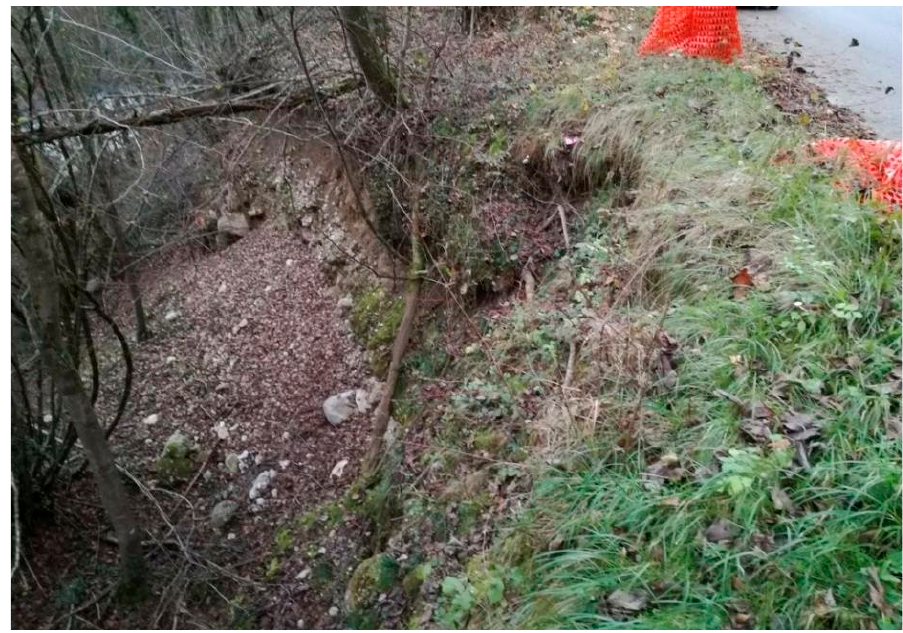
Figure 3. Landslide photograph code 025021_01c.